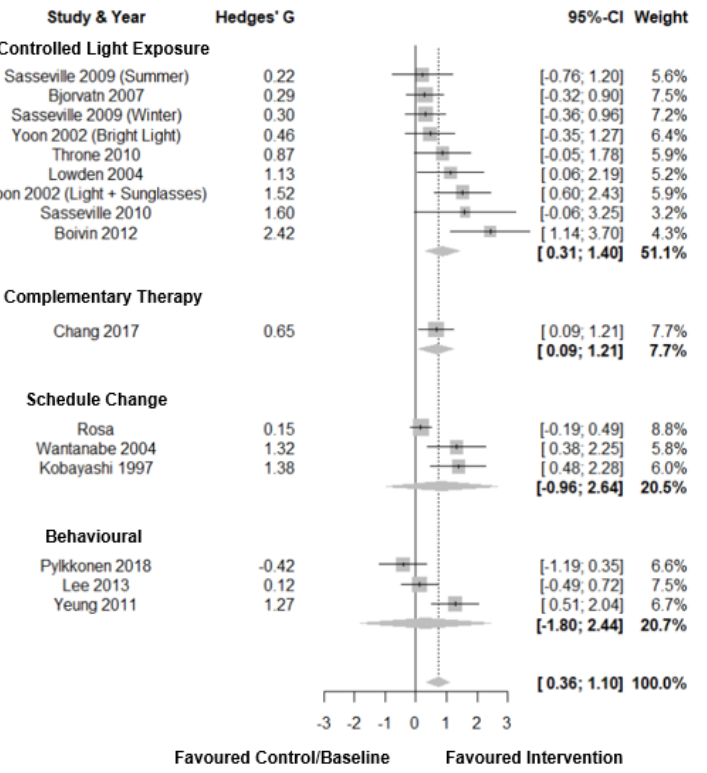
Figure 5. Forest plot for intervention by type on objective sleep duration. Note. Interventions with multiple conditions are denoted within brackets.